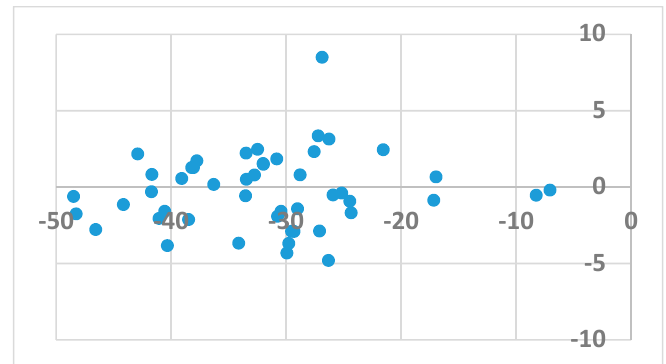
Figure 1. The signed difference in averaged HYDE score between binding to wild type enzyme vs. binding to mutants as a function of the binding score. Table 1. Averaged HYDE docking scores for all ligands docked to wild type (wt) and mutated human immunodeficiency virus 1 (HIV-1) reverse transcriptase structures.